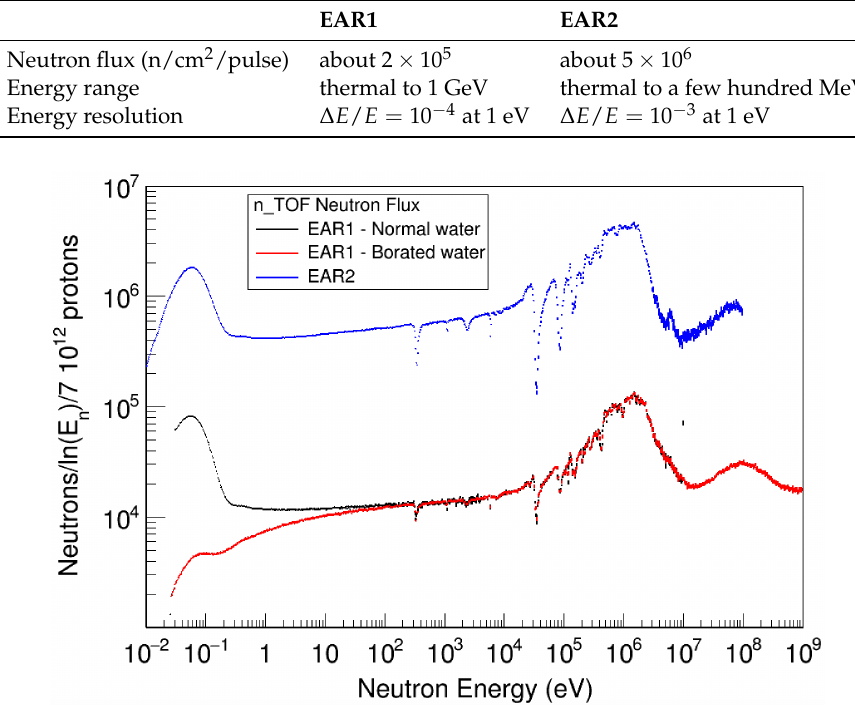
Figure 2. Neutron flux in EAR1 (black and red lines) and EAR2 (blue line) as a function of the neutron energy. The flux is presented per nominal proton bunch (7 × 10 12 protons) in isolethargic units. In the low neutron energy region, the difference resulting in using normal (black) or borated (red) water can be seen. Data from Reference [10] for EAR1 and from Reference [6] for EAR2